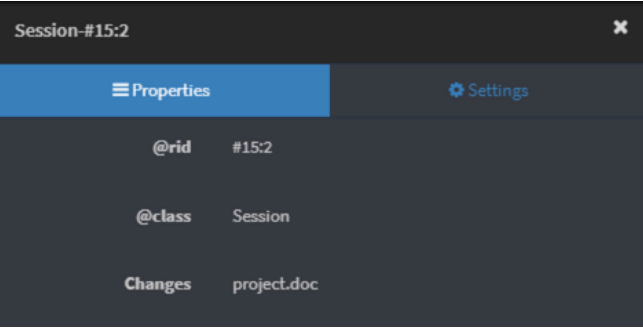
Figure 3. Example of partially information about Session